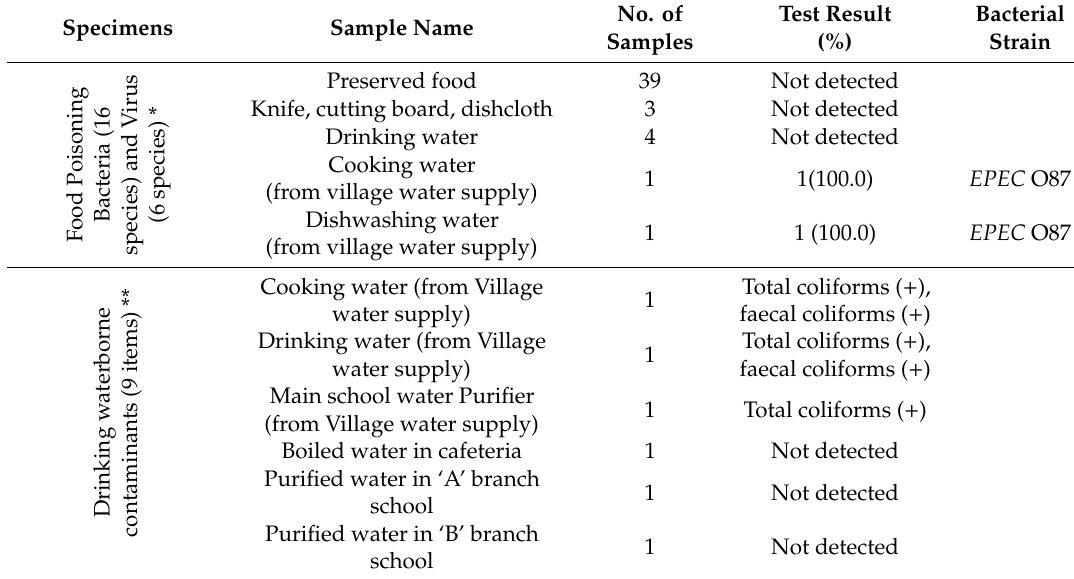
Table 3. Laboratory tests of the food and environmental